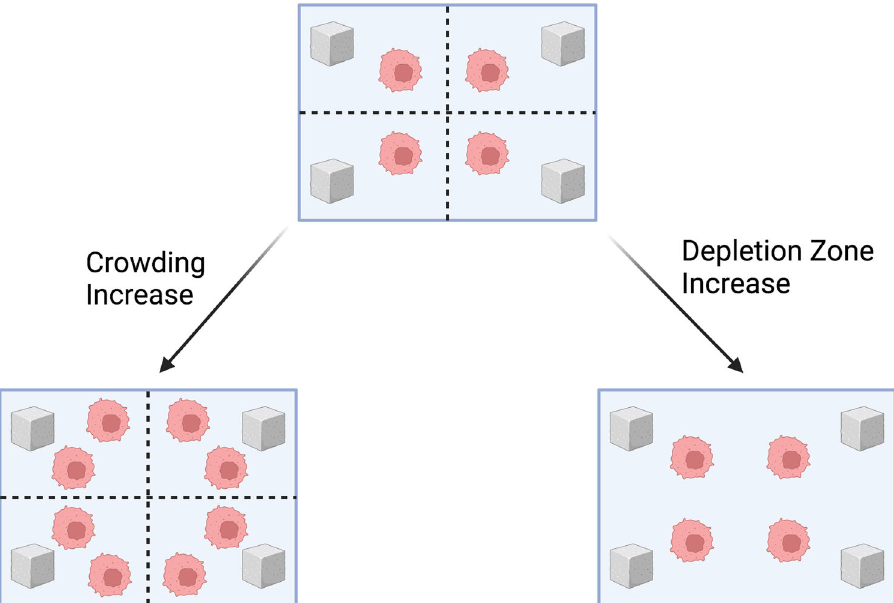
Fig. 12 Illustration of the differences between crowding and depletion zone increase assumptions. Sugar cubes represent glucose molecules, the cell depicted is a cancerous one, and the black lines divide the environment into depletion zones. With the “ crowding increase" assumption, the size of the depletion zone and nutrient availability are held constant while the cell density per unit area increases, reducing nutrient availability per cell. In the “ depletion zone increase" assumption, both nutrient availability and size of the depletion zone are increased, keeping cell density per unit area and nutrient availability per cell constant. Created with